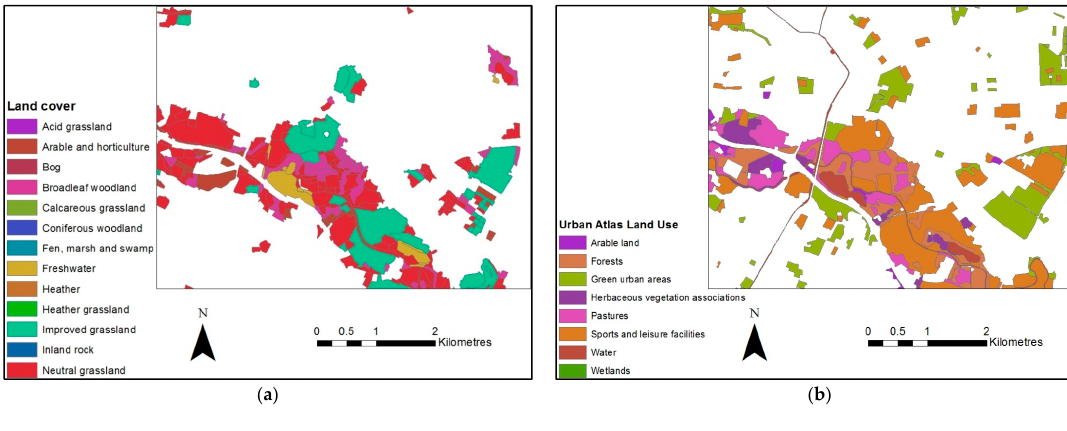
Figure 6. Distribution of green land cover values: Integrated Landscape Map.